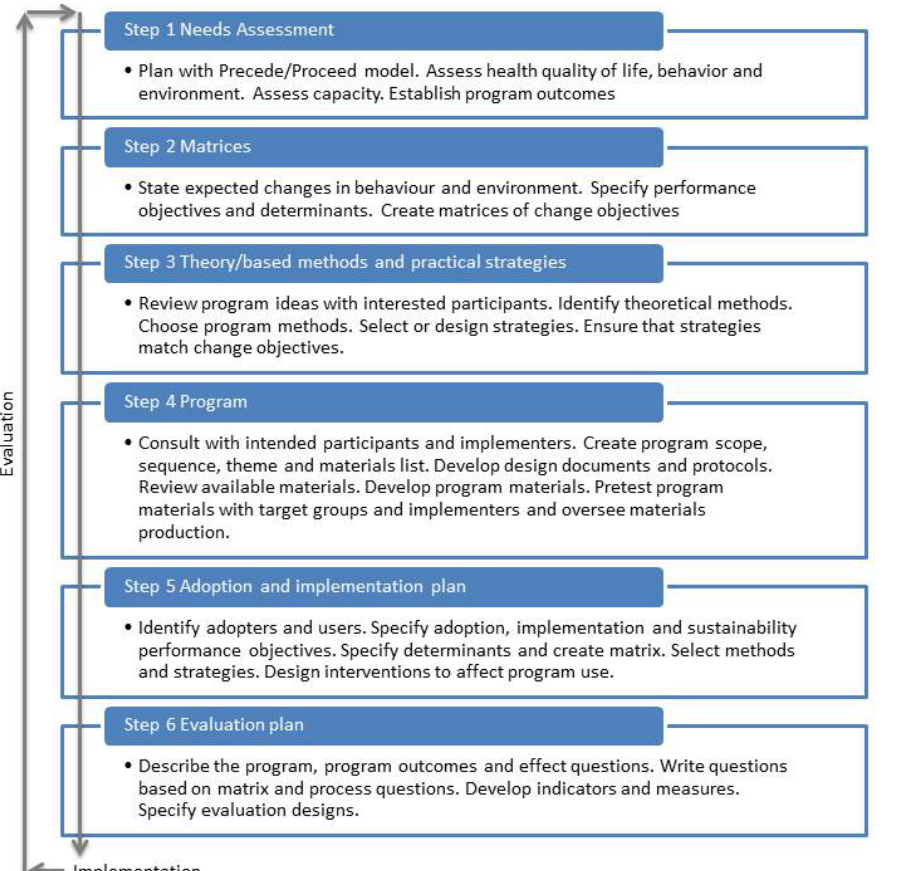
Figure 2. Intervention Mapping